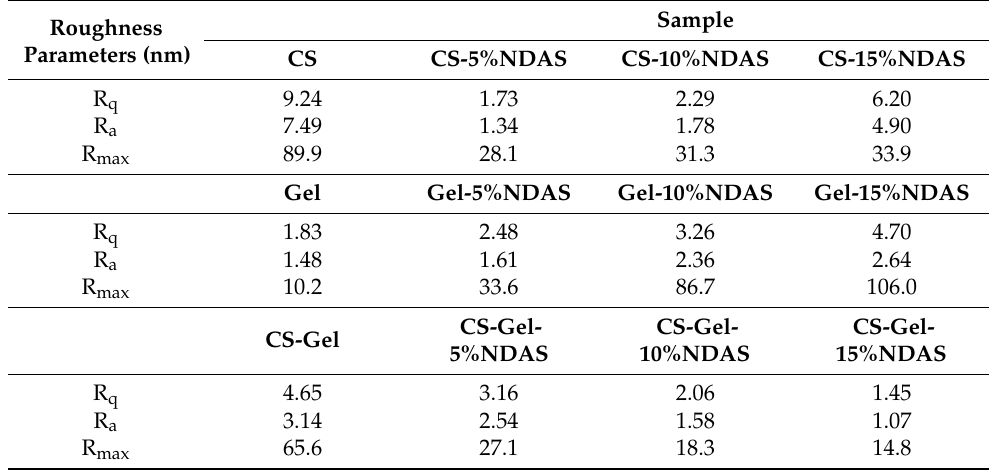
Table 2. The roughness parameters of chitosan, gelatin, and chitosan–gelatin films cross-linked with